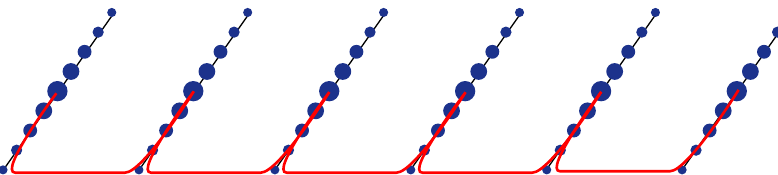
Figure 7: (Color online) Schematic representation of a state in a comb with an odd number of sites per tooth. Each tooth is in the state with s = 1 / 2, which is delocalized along the tooth. When the backbone interaction is sufficiently small, a maximal prob- ability to find spin-1 / 2 is approximately in the middle of each tooth. So the distance between two spin-1 / 2 degrees of freedom is proportional to L and the entire length of the effective chain is proportional to ( N L ) . Upon increasing the backbone interac- tion, this maximum of the spin-1 / 2 profile on a tooth moves towards the backbone but in a non-uniform